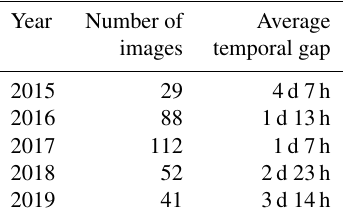
Table 1. Years of Sentinel-1 EW data and associated numbers of images and average temporal